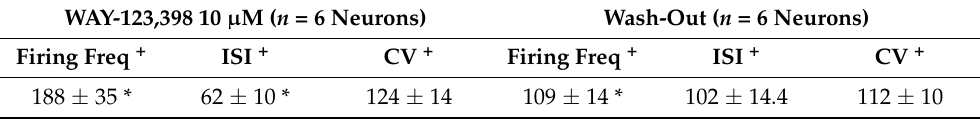
Table 1. Effects of WAY application on firing properties and firing pattern of LC neurons.